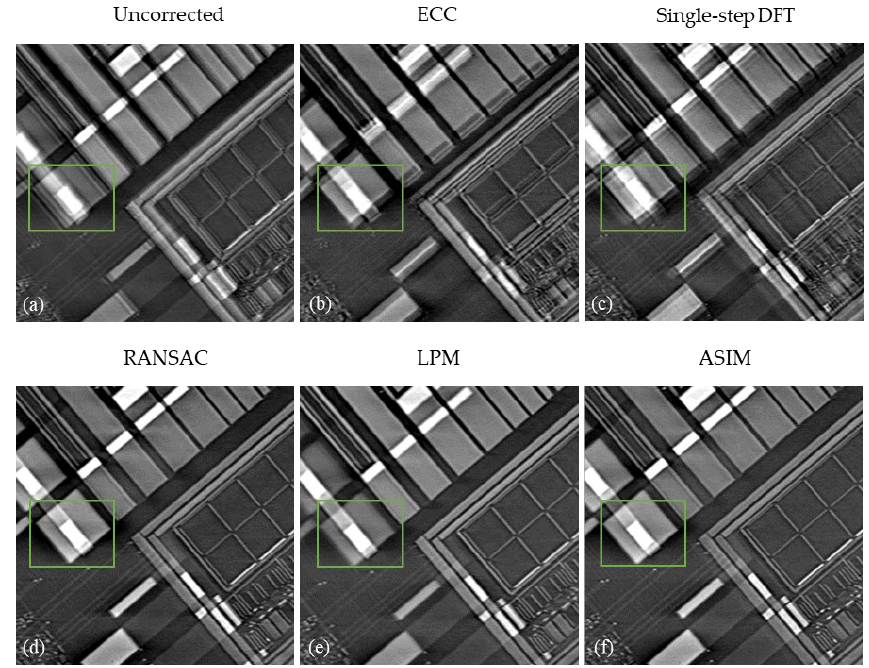
Figure 8. Correction results of electronic component. ( a ) Uncorrected. ( b ) ECC. ( c ) Sigle-step DFT. ( d ) RANSAC. ( e ) LPM. ( f ) ASIM.